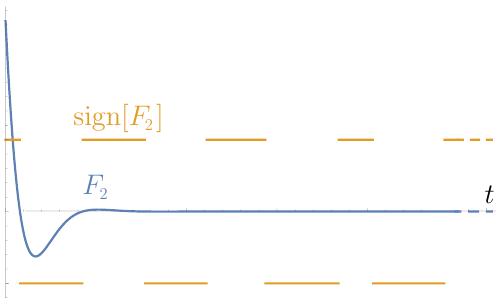
Figure 12. Plot of a typical F 2 observable and its sign in AdS 5 BH. In contrast with the F 2 of the BTZ scenario in figure 10(a), the excited state relaxes via a series of absorption and re-emission processes. This is directly related with the fact that the lowest QN state in any higher dimensional BH is already complex, as opposite to the BTZ case in which is pure